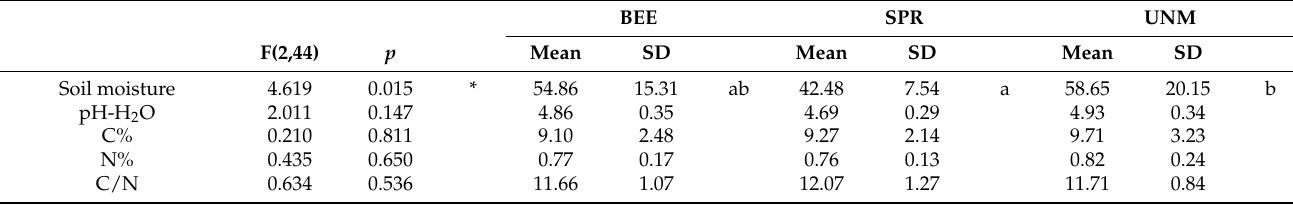
Table 1. Mean and standard deviation (SD) of soil moisture, soil pH (H 2 O), soil carbon content (C%), soil nitrogen content (N%), and the proportion of carbon and nitrogen (C/N) in three forest types: BEE—European beech Fagus sylvatica L.;